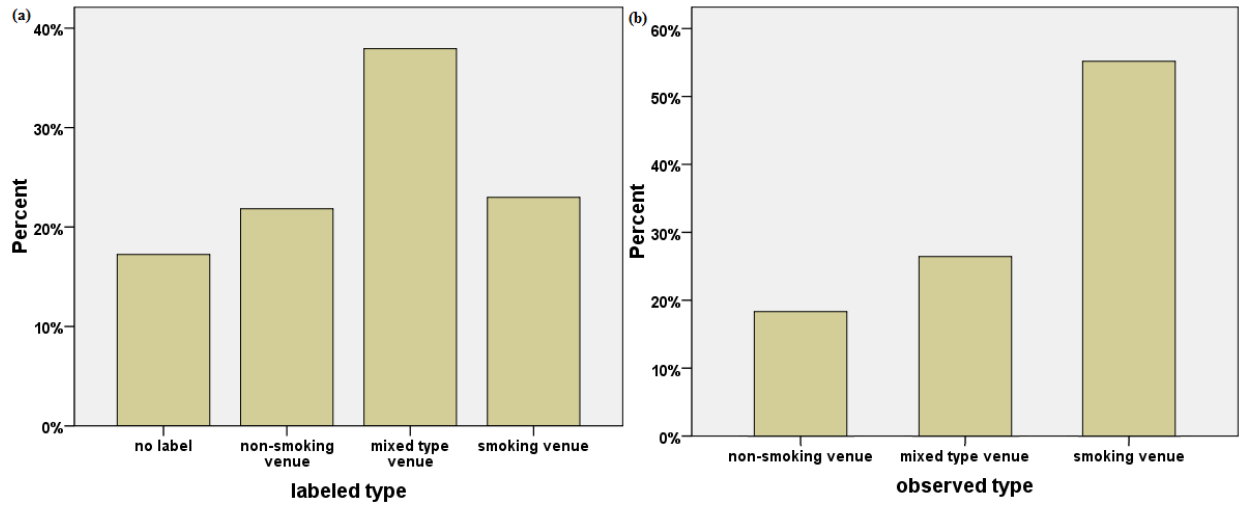
Figure 4. Frequency of hospitality venue types according to ( a ) the labels we found and ( b ) the routine we observed. Note the „shift‟ from unmarked and alleged mixed type facilities to exclusive smoking ones (If not otherwise specified in the text, the observed venue type was used to describe a